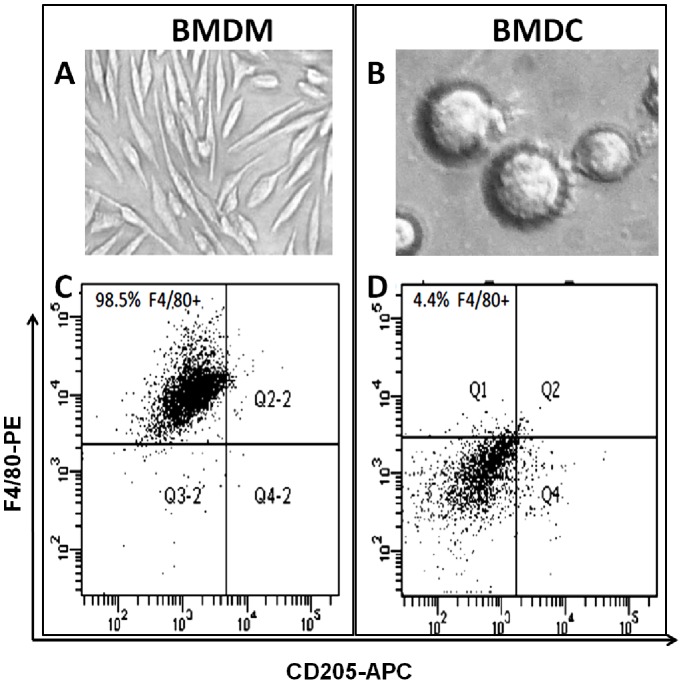
Morphology and immunophenotype of bone marrow-derived macrophages (BMDM) and dendritic cells (BMDC).Five-day cultures of BMDM generated with 30% L929-conditioned medium (A) or BMDC generated with 20 ng/mL GM-CSF and IL-4 (B); images were taken at 200x+digital zoom. Over 98% of the BMDM were F4/80+ (C), but less than 4.5% of the macrophage-depleted BMDC were F4/80+ (D).